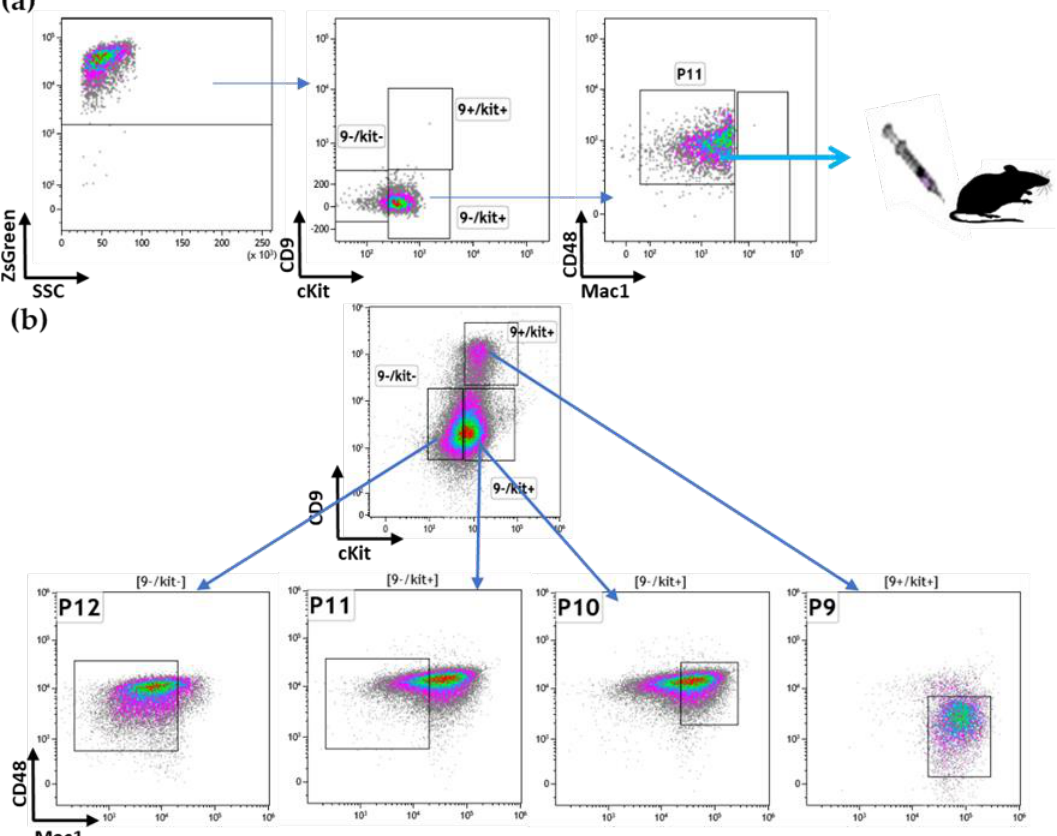
Figure 3. P11 LSC can reconstitute the heterogeneity of ML23: ( a ) Sorted P11 sub-population (CD9-cKit+Mac1-CD48+), which were transplanted into the recipient mice. ( b ) P11 sub-population reconstituted the heterogeneity of ML23 in the recipient mice (the primary recipient of P11-sorted cells). Representative data are shown from one out of three independent experiments.